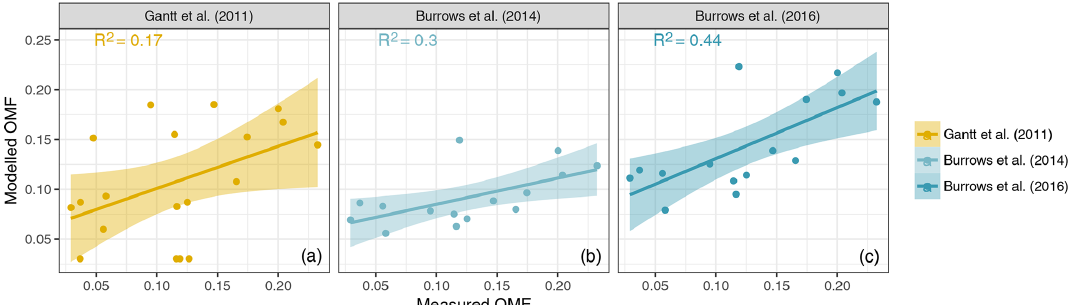
Figure 11. PM 1 OMF modelled using parameterisation from Gantt et al. (2011) (a) , OCEANFILMS-1 (b) and OCEANFILMS-2 (c) com- pared to that measured in this study. Lines show the linear fit between modelled and measured OMF; shading shows the 95% confidence interval in the linear model. Fit parameters for Gantt et al. (2011): R 2 of 0.17, p value < 0.05 and slope of 0 . 4 ± 0 . 2. Fit parameters for OCEANFILMS-1: R 2 of 0.3, p value < 0.05 and slope of 0 . 3 ± 0 . 1. Fit parameters for OCEANFILMS-2: R 2 of 0.44, p value < 0.01 and slope of 0 . 5 ± 0 . 1.